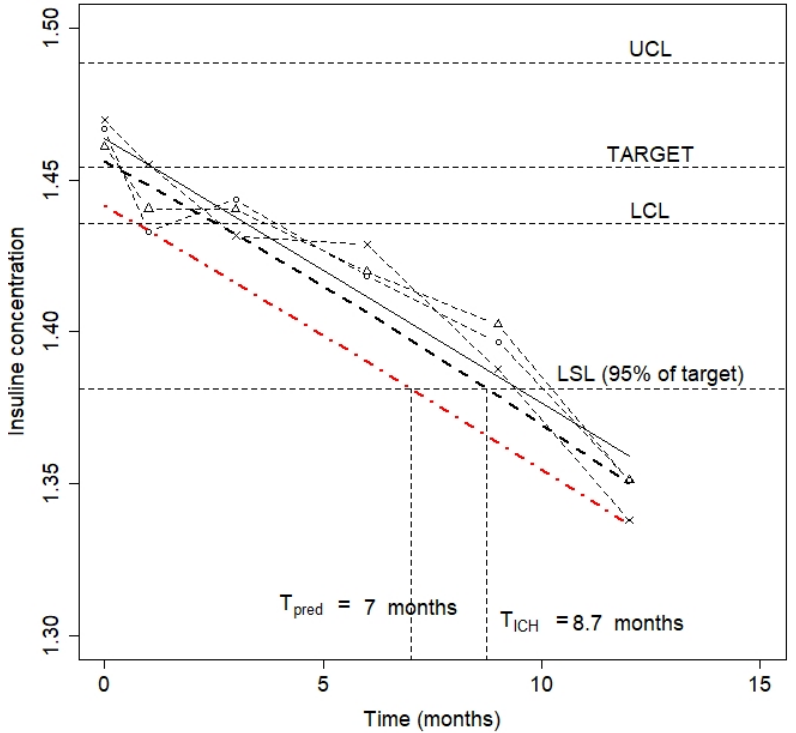
Figure 2. Stability profile.